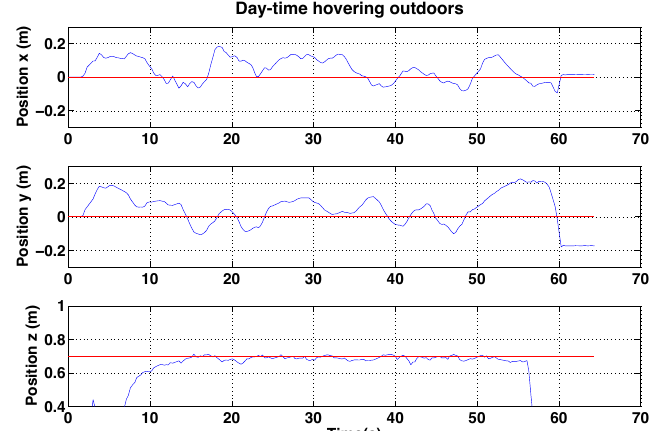
Figure 31. Experimental results for IBVS-based hovering: control performance for outdoor day-time IBVS-based hovering. Goal positions shown in